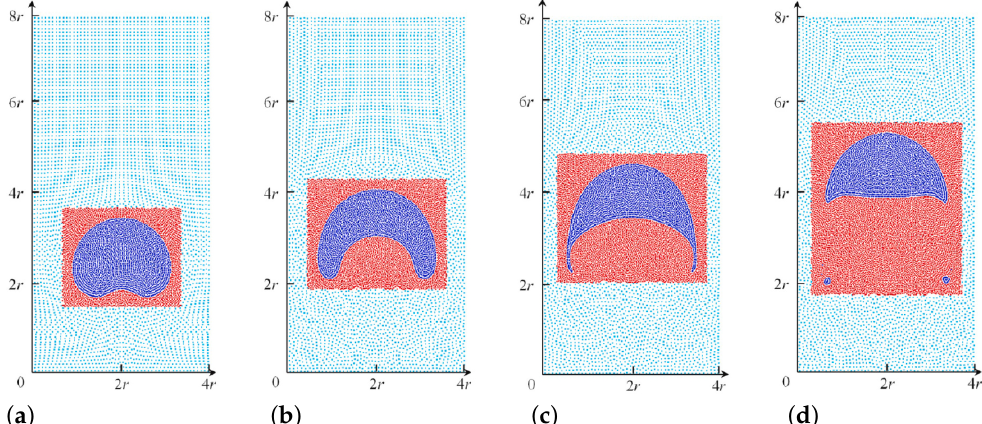
Figure 7. SPH simulations of the rising bubble at different time instants with the APR-SPH tech- nique [138]. ( a ) t = 0.3 s; ( b ) t = 1.5 s; ( c ) t = 2.2 s; ( d ) t = 3.0 s.